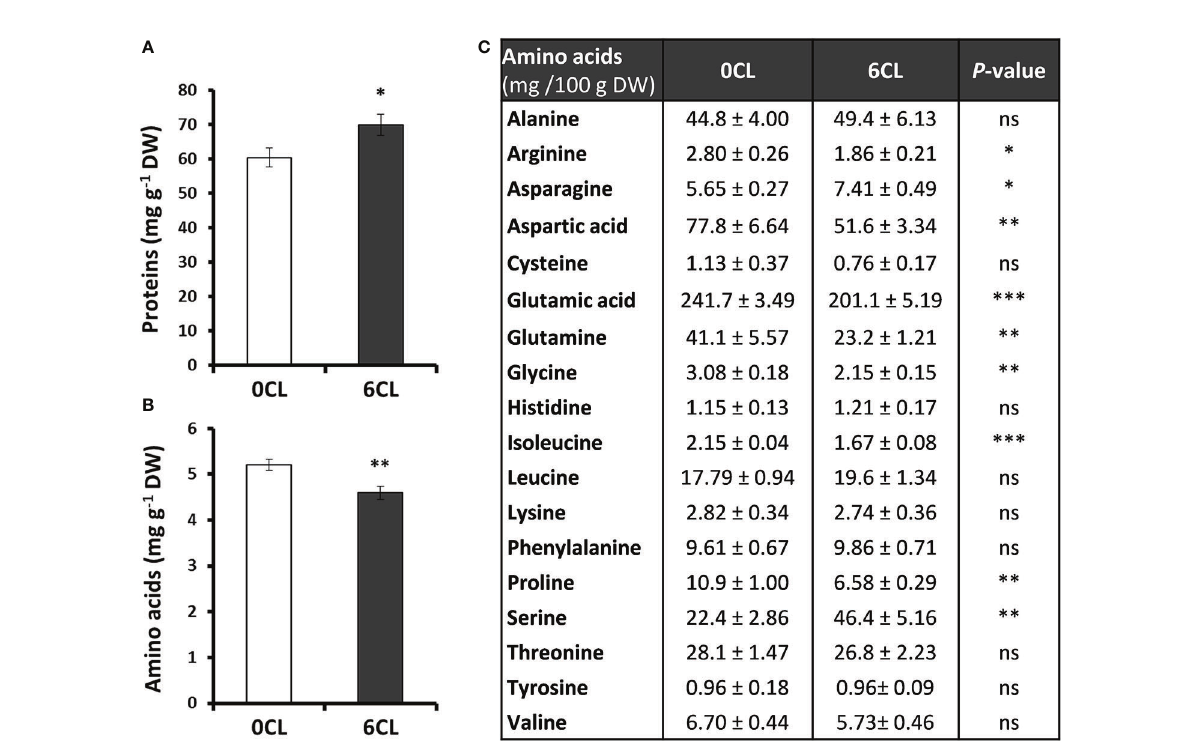
FIGURE 5 Effect of Cl − nutrition on protein and amino acids content. Tobacco plants were treated with 0 and 6 mM of Cl − salts (CL), and supplemented with a mix of sulphate+phosphate salts to maintain a similar cationic balance. (A) Total proteins content; (B) Total free amino acids content; (C) Amino acids pro fi le. Mean values ± SE, n =4-6. Statistics was calculated through ANOVA, where mean values with different letters are signi fi cantly different according to Tukey ’ s test at P ≤ 0.05. Levels of signi fi cance: * P ≤ 0.05; ** P ≤ 0.01; *** P ≤ 0.001; and ‘ ns ’ P >